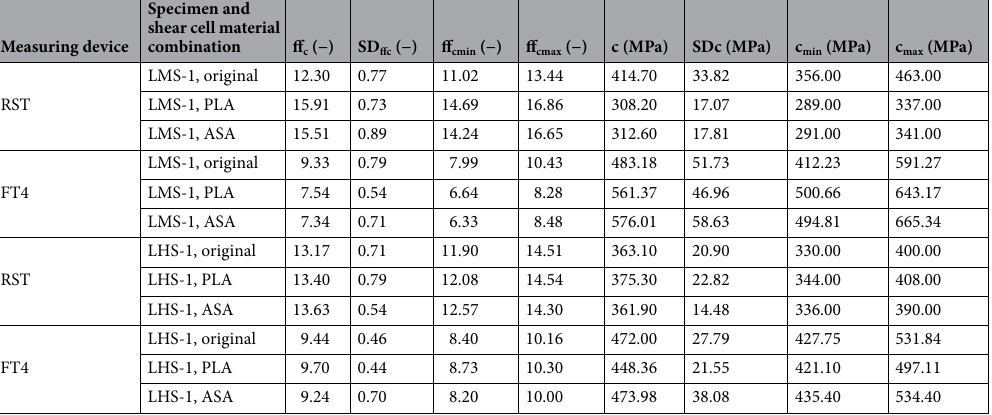
Table 4. Shear test results—flow function ff c and cohesion c